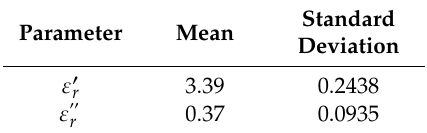
Table 4. Obtained results for the complex relative permittivity of